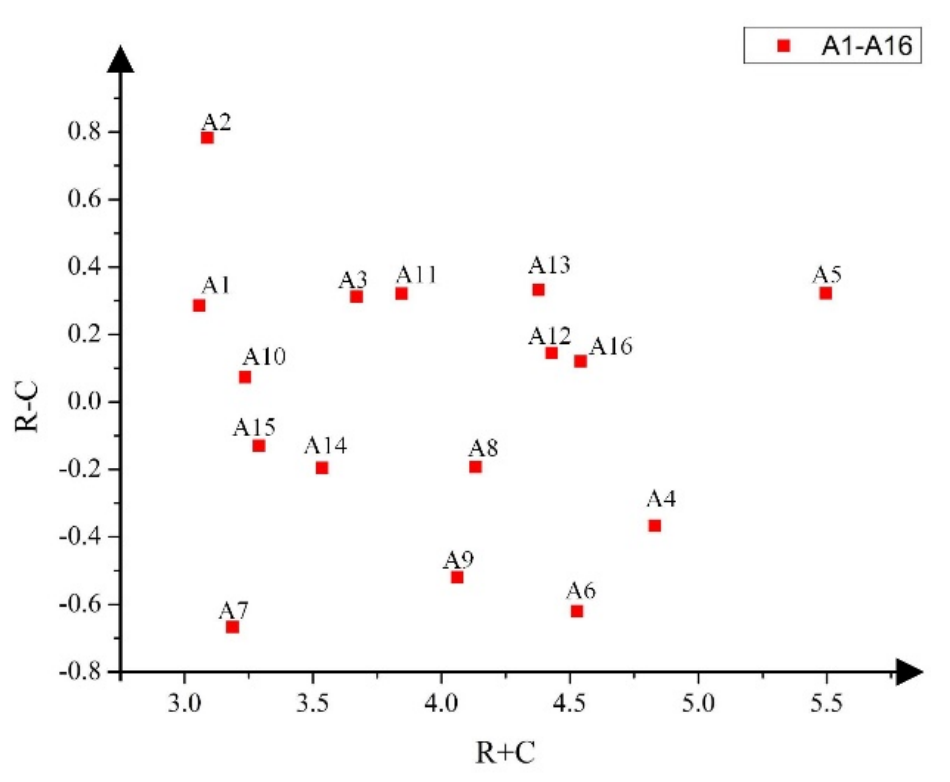
Figure 3. Cause–effect relation diagram.